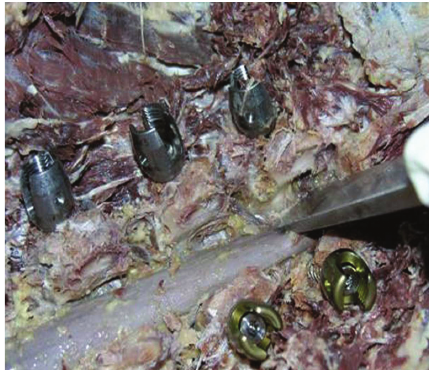
Figure 5: Intact medial pedicle walls after laminectomy following insertion of 10-degree screws without force application.